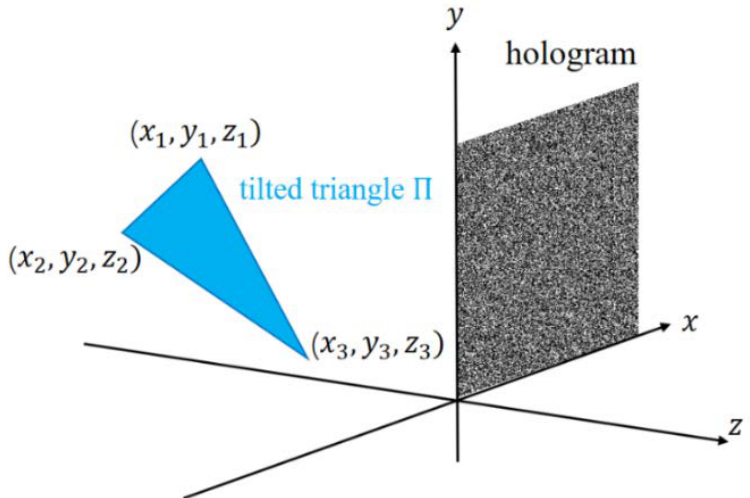
Figure 3. Tilted triangle Π in global coordinate system ( x , y , z ) and hologram plane ( z = 0 ) . We now define the affine coordinates ( s , t , p ) as our input coordinates, as shown in Figure 4. A primitive triangle ∆ with vertexes ( s 1 , t 1 , p 1 ) , ( s 2 , t 2 , p 2 ) and ( s 3 , t 3 , p 3 ) is in the affine coordinate system, and the analytical expression of the primitive triangle spectrum is obtained by using two-dimensional Fourier transform for p = 0. The spectrum of the tilted triangle is finally obtained from the affine relationship between the primitive triangle ∆ and the tilted triangle Π with the analytical expression of the primitive triangle spectrum derived from the Fourier transform.